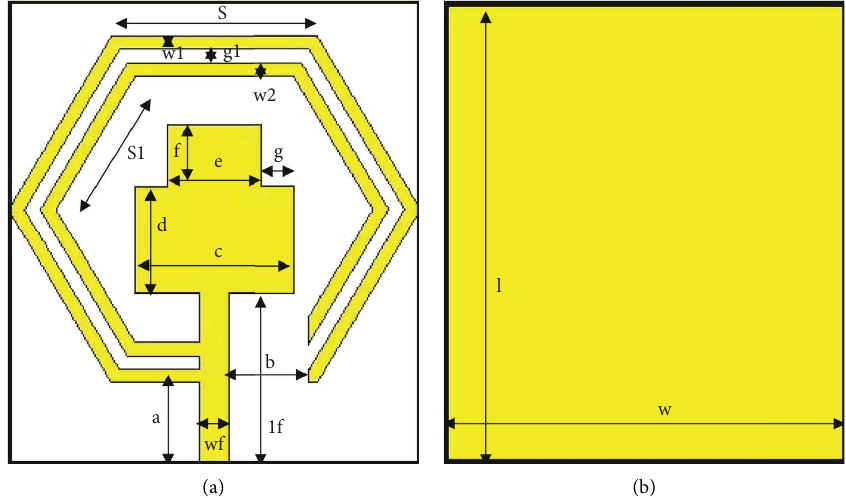
Figure 2: Final proposed low-SAR penta-band microstrip patch antenna with its design parameters. (a) Front view. (b) Back